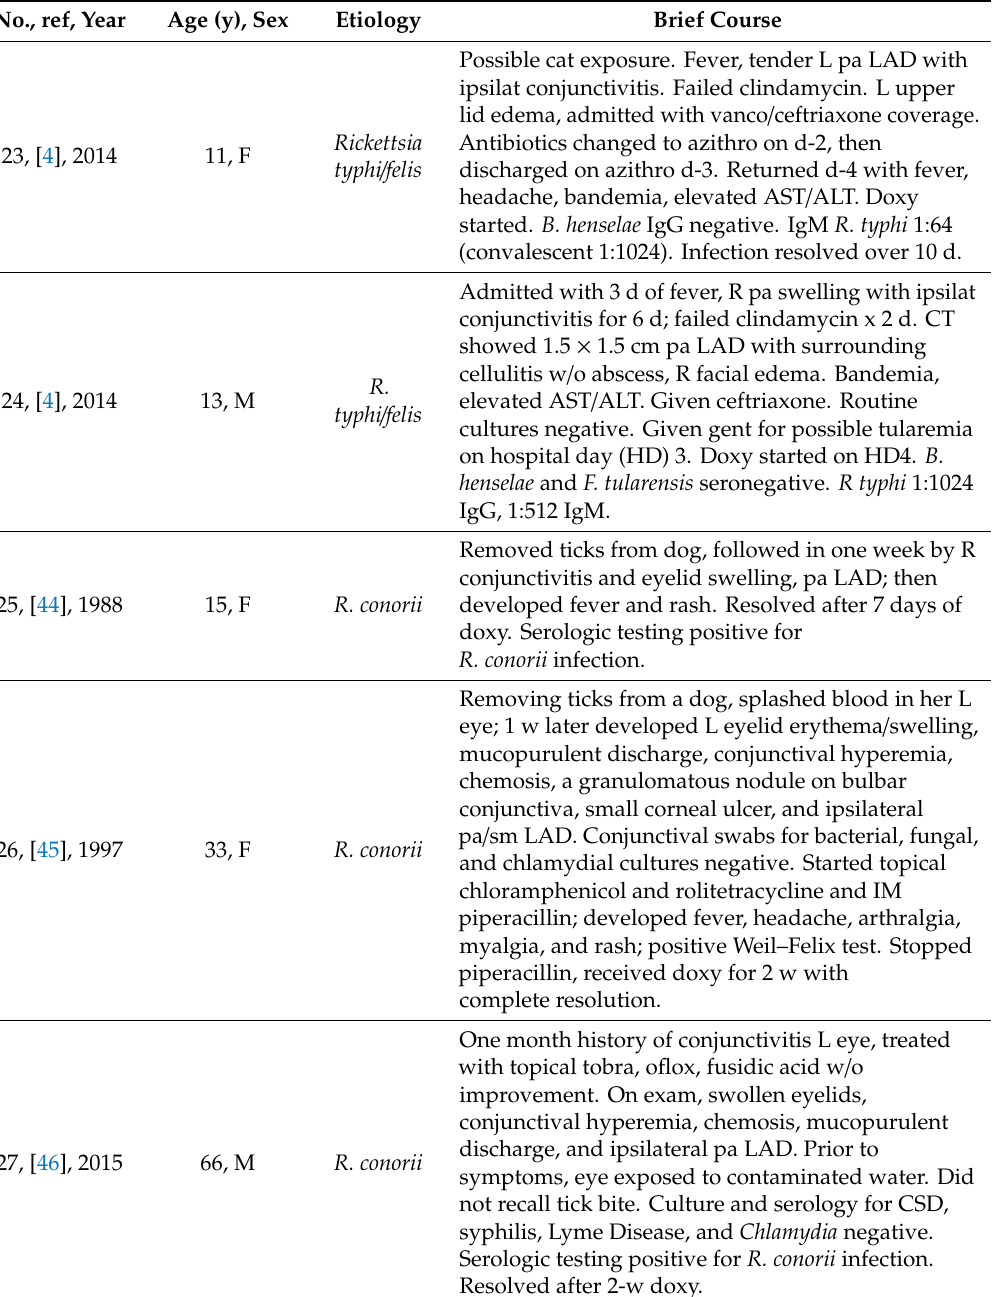
Table 4. Parinaud’s oculoglandular syndrome in rickettsial